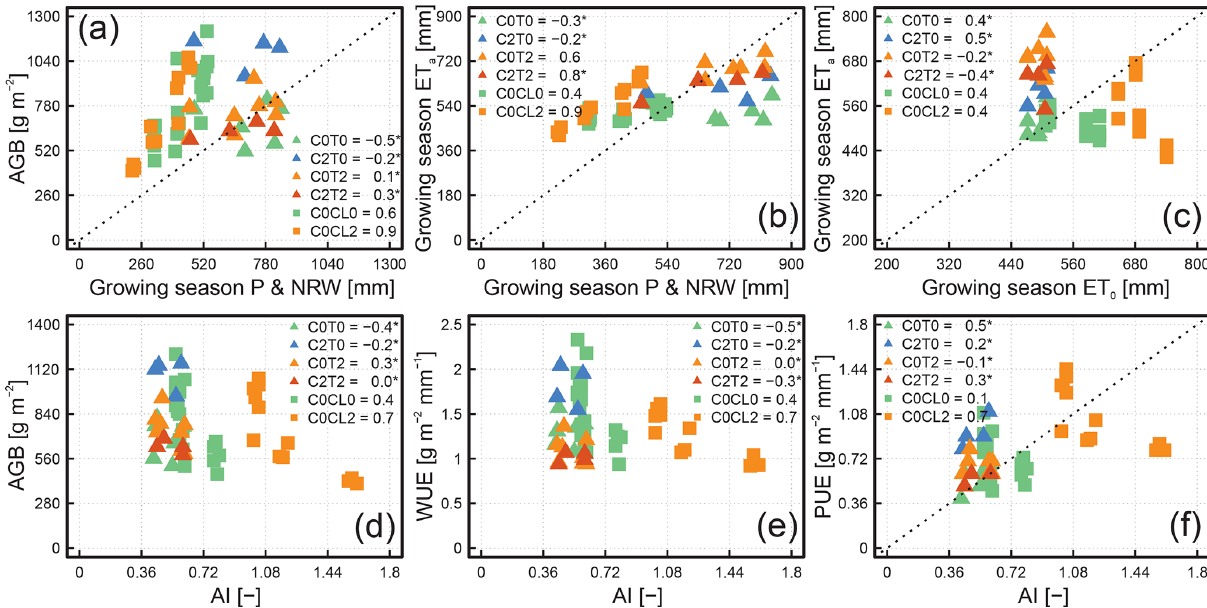
Figure 5. Scatterplots of aboveground biomass (AGB) to growing season precipitation ( P ) and non-rainfall water (NRW; a ), growing season evapotranspiration (ET a ) to growing season P and NRW (b) , growing season ET a to growing season grass-reference evapotranspiration (ET 0 ; c ), AGB to aridity index (AI; d ), water use efficiency (WUE) to AI (e) , and precipitation use efficiency (PUE) to AI (f) . In each subplot, variables are shown for all treatments from the manipulative (Lysi-T-FACE C2T0, C0T0, C0T2, and C2T2) and observational climate change approaches (TERENO-SOILCan; Rollesbroich – C0CL0; Selhausen – C0CL2) for the period 2015 to 2018. The adjusted R 2 values for each soil ecosystem are given in the legend, and the asterisk means that the linear relationship was not statistically significant ( p value > 0 .